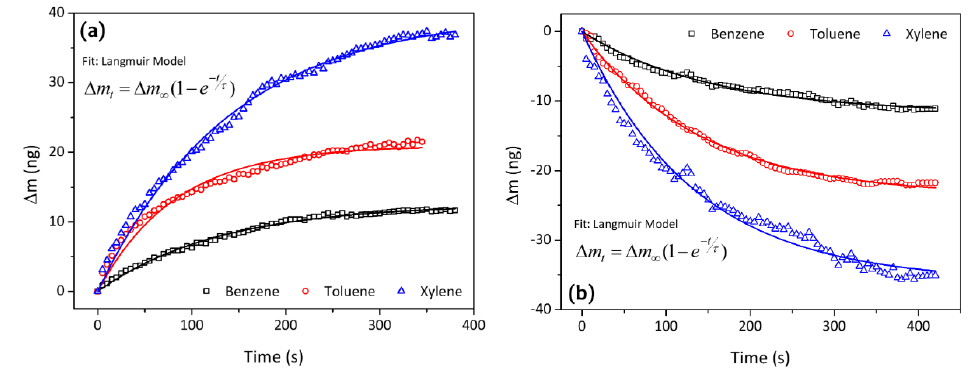
Figure 7. Least squares fit using the Langmuir adsorption isotherm model for QCM-PVAc film sensor against BTX, ( a ) response and ( b ) recovery.